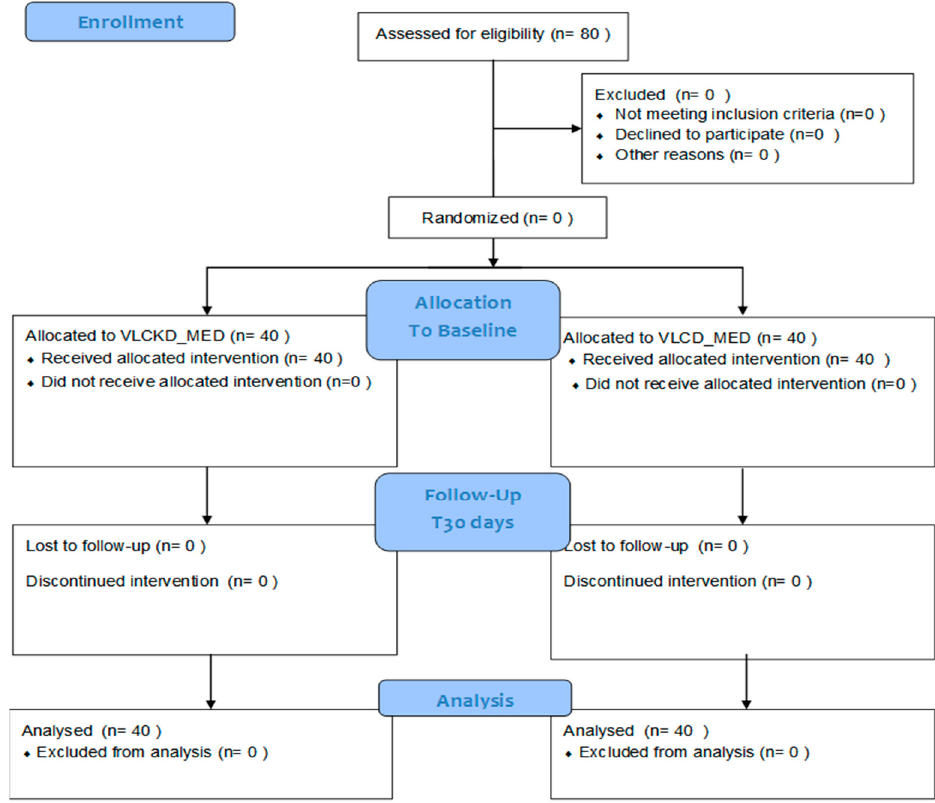
Figure 1. VLCKD_MED: very-low-calorie ketogenic Mediterranean diet and VLCD_MED: very-low-calorie Mediterranean diet.